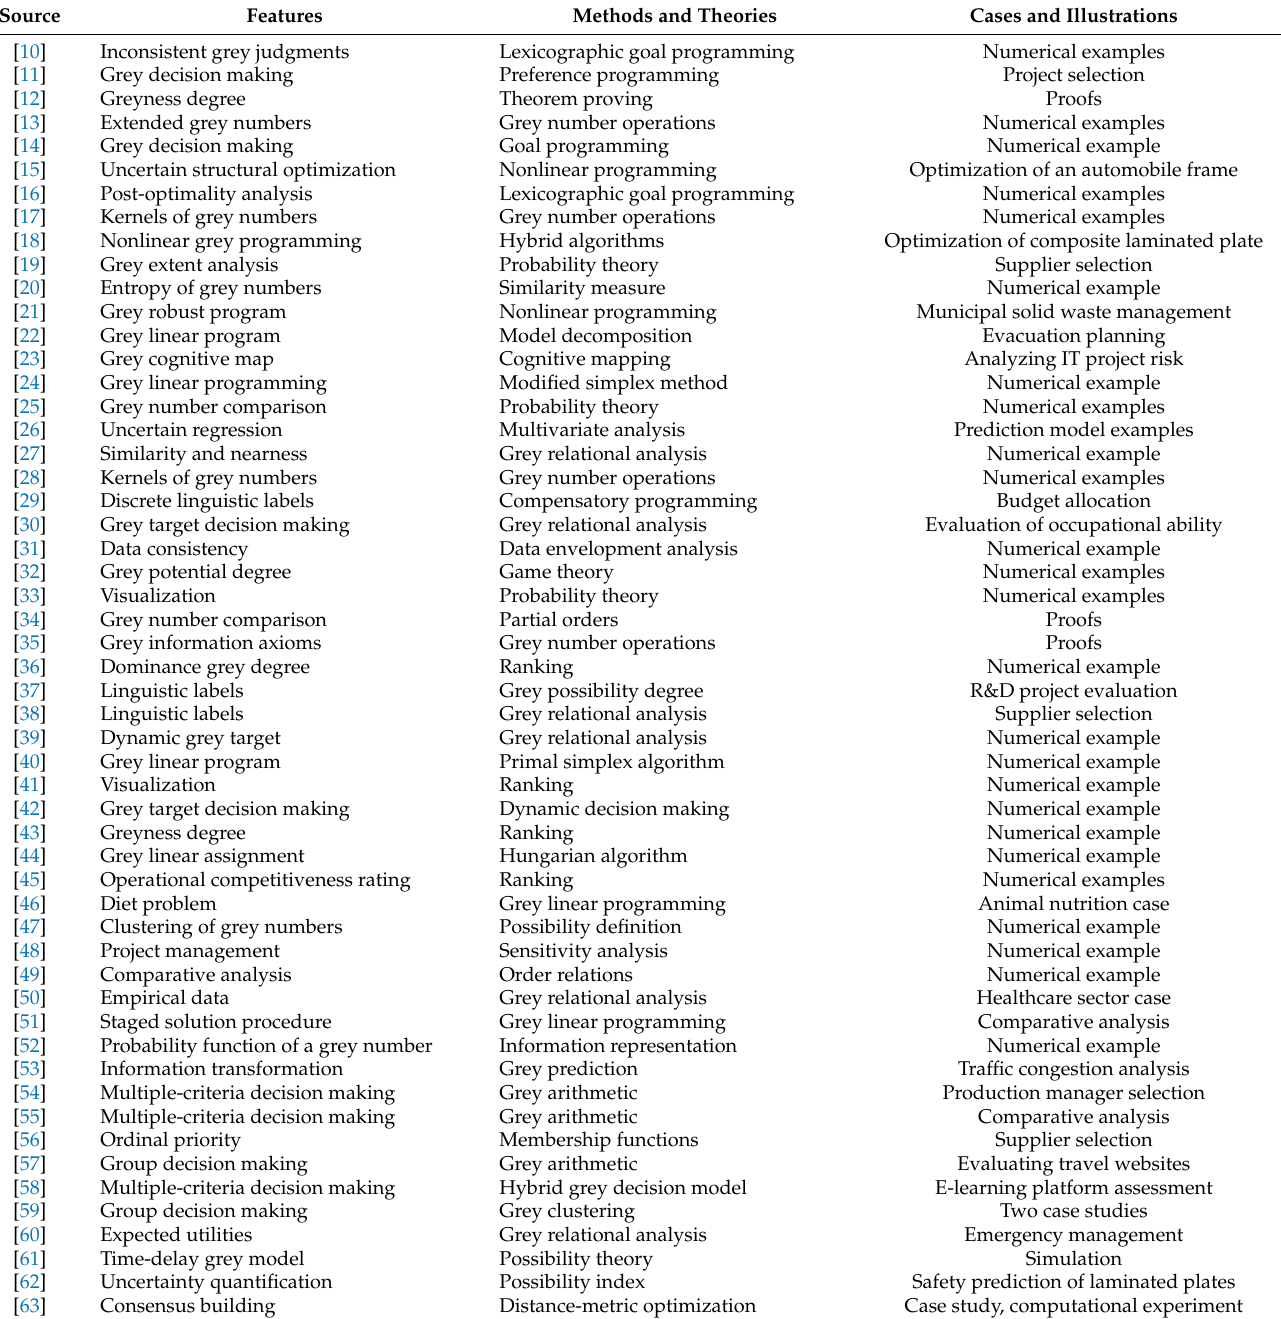
Table 1. Summary of subject literature on grey